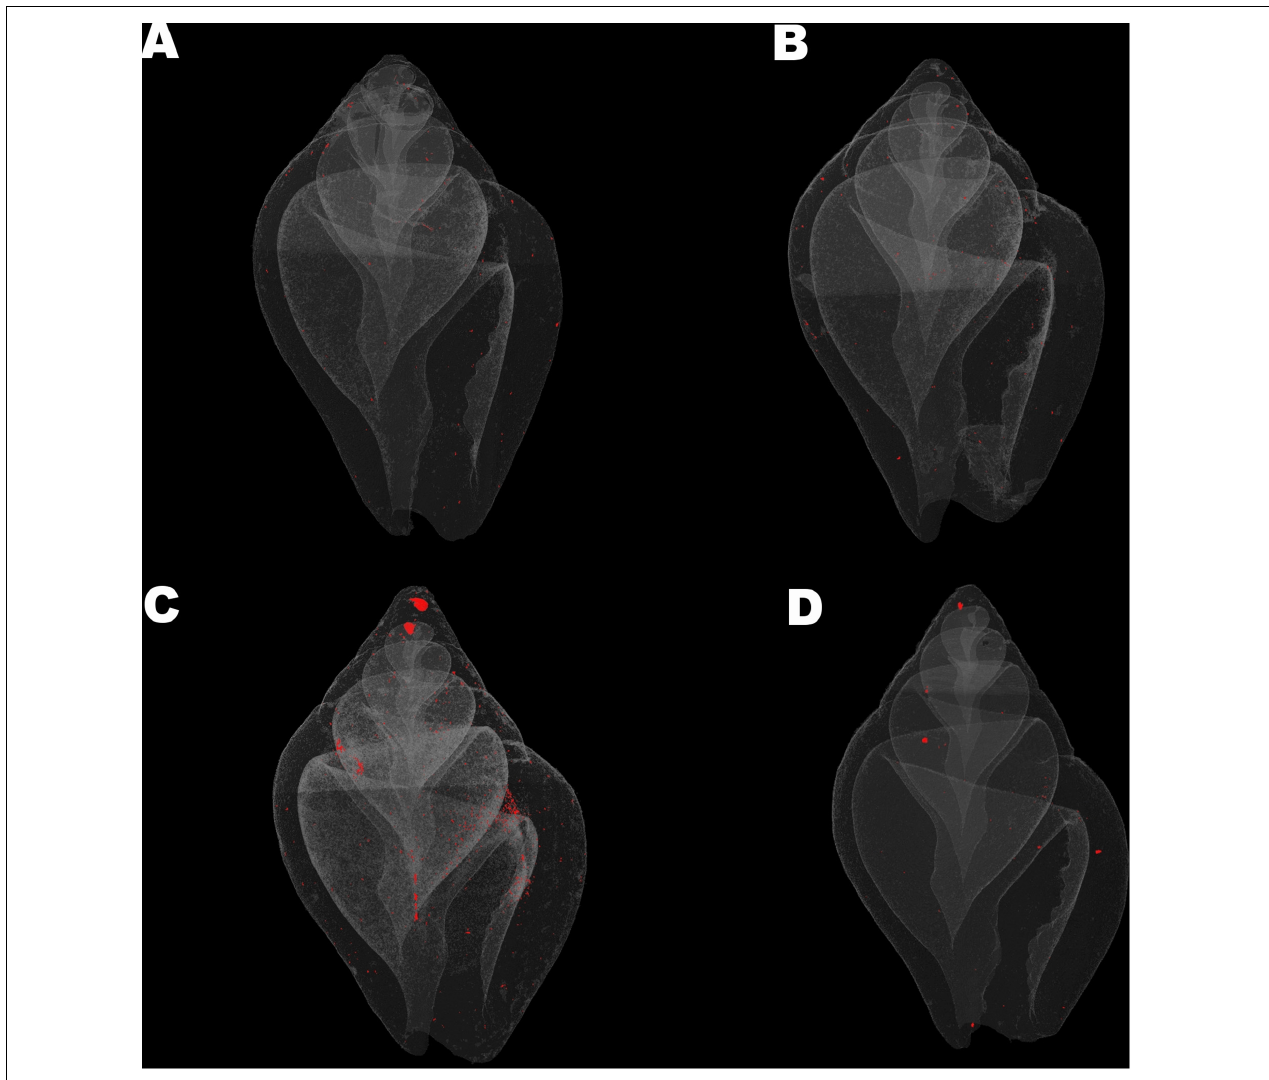
FIGURE 4 | Visualization of shell closed porosity for Collumbela rustica in the four experimental treatments (A) (7A), (B) (8A), (C) (7W), and (D) (8W) as coded in the text (8A: 20 ◦ C and pH = 8; 7A: 20 ◦ C and pH = 7.7; 8W: 23 ◦ C and pH = 8; 7W: 23 ◦ C and pH =